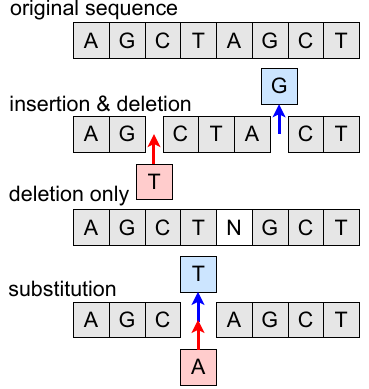
Figure 2. An illustration of three DNA sequence edit augmentation ways. Tokens A , G , C , T denote four types of deoxyribonucleotides and token N denotes unknown basic group or null token. Red arrows denote inserting and blue ones denote